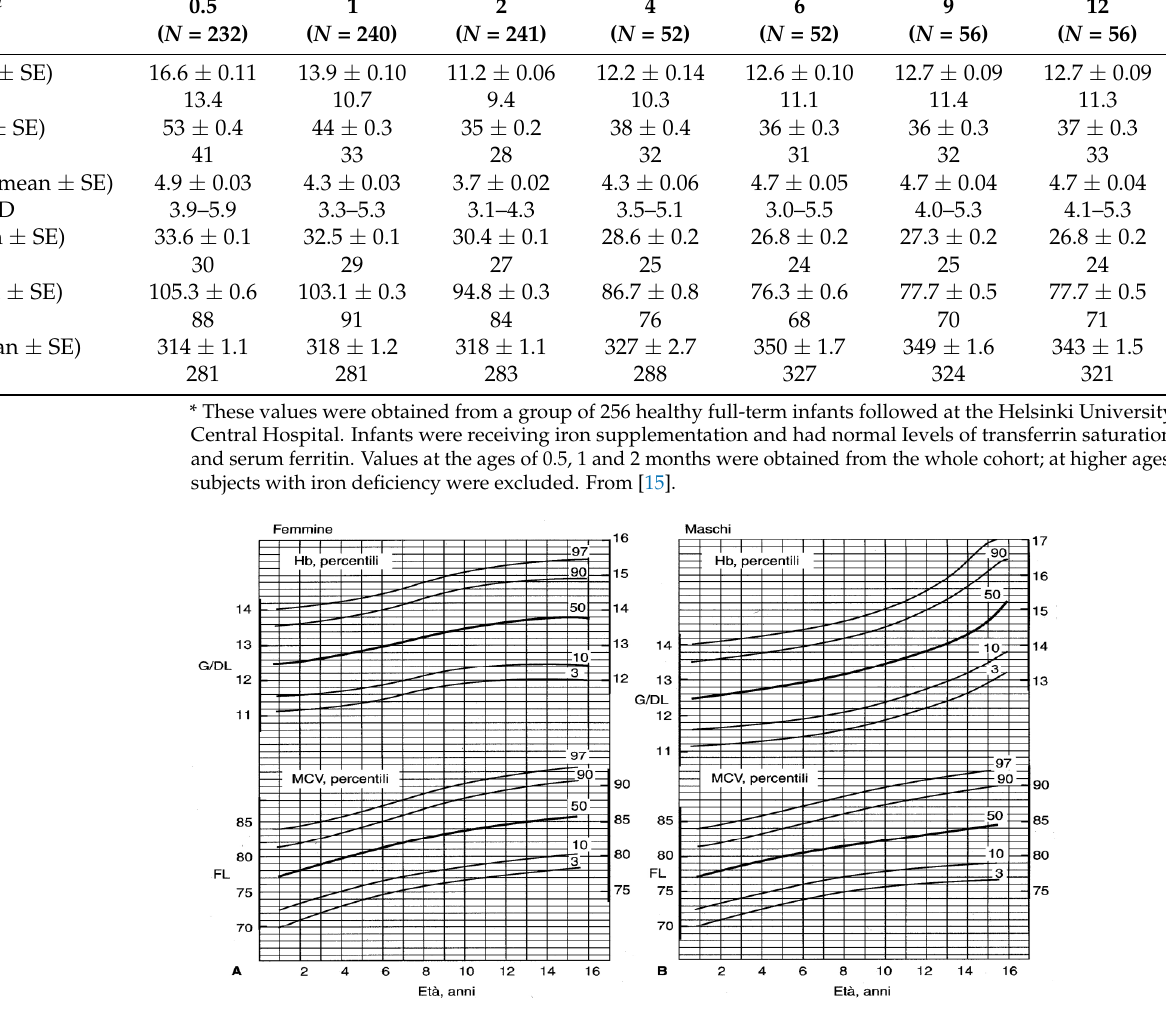
Figure 1. Percentile curves of hemoglobin (Hb) values and mean corpuscular value (MCV) in females ( A ) and males ( B ) in the first 15 years of life (from [16]). RDW is a faster and simpler but less complete measure of the degree of anisocytosis than the blood smear. Generally, a wide RDW is observed in iron deficiency, whereas in be altered in various heart and liver pathologies [18].